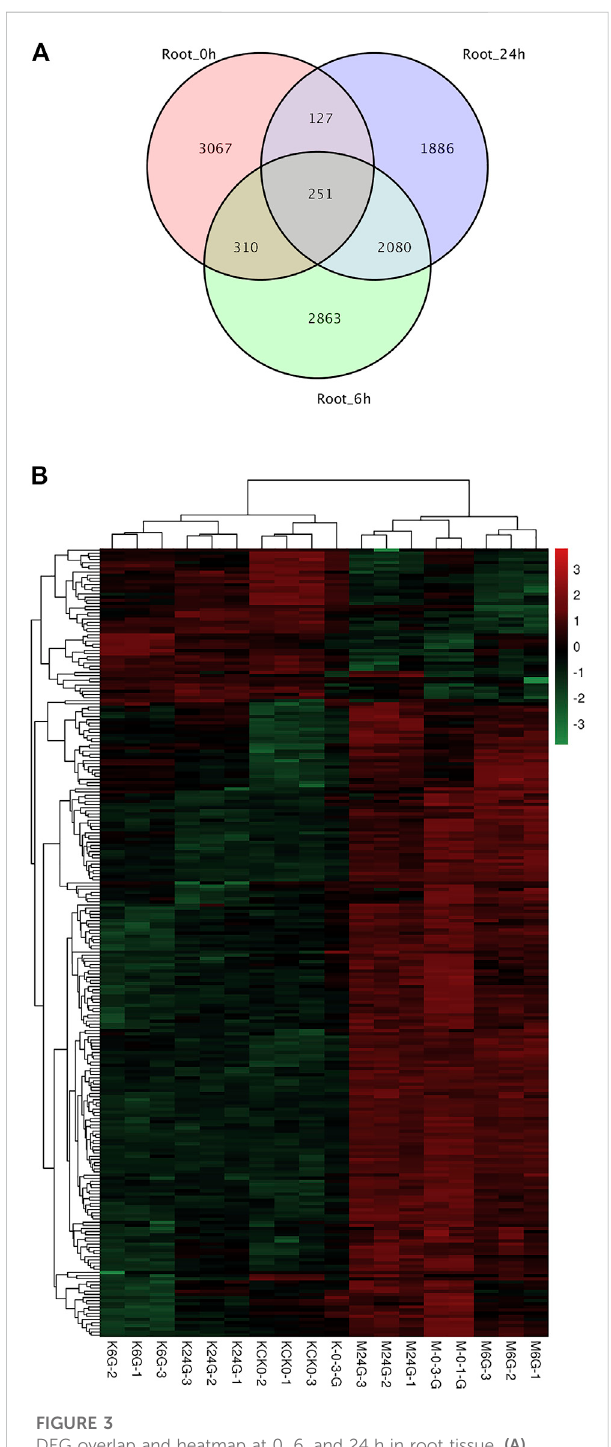
FIGURE 3 DEG overlap and heatmap at 0, 6, and 24 h in root tissue. (A) Overlap of DEGs at three time points. (B) Heatmap of 251 DEGs for all three time